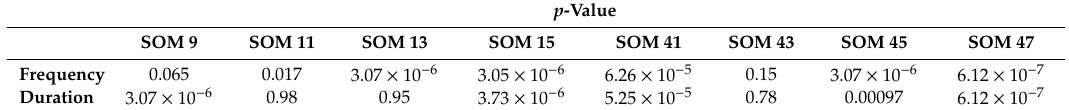
Table 3. Results of the statistical test for SOM frequency and SOM duration.